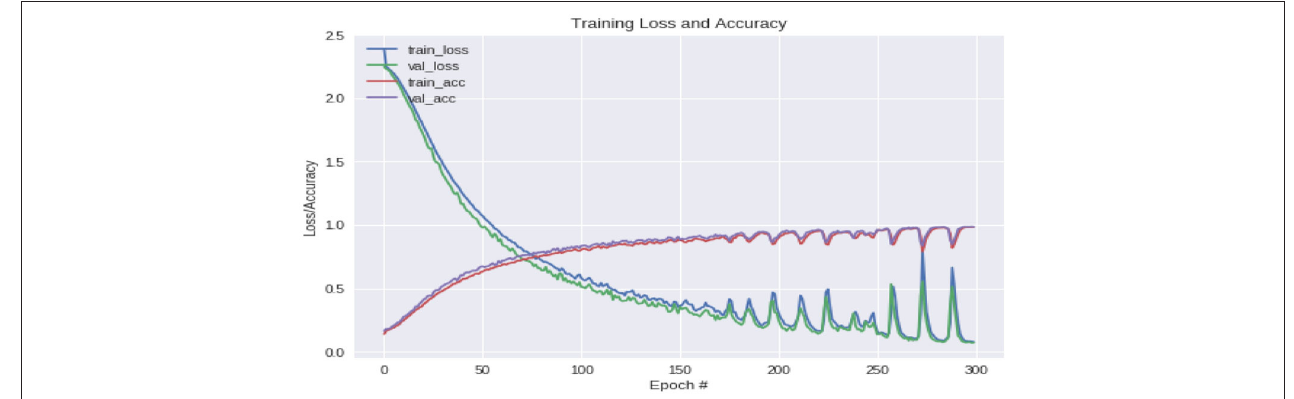
FIGURE 7 | Training loss and accuracy